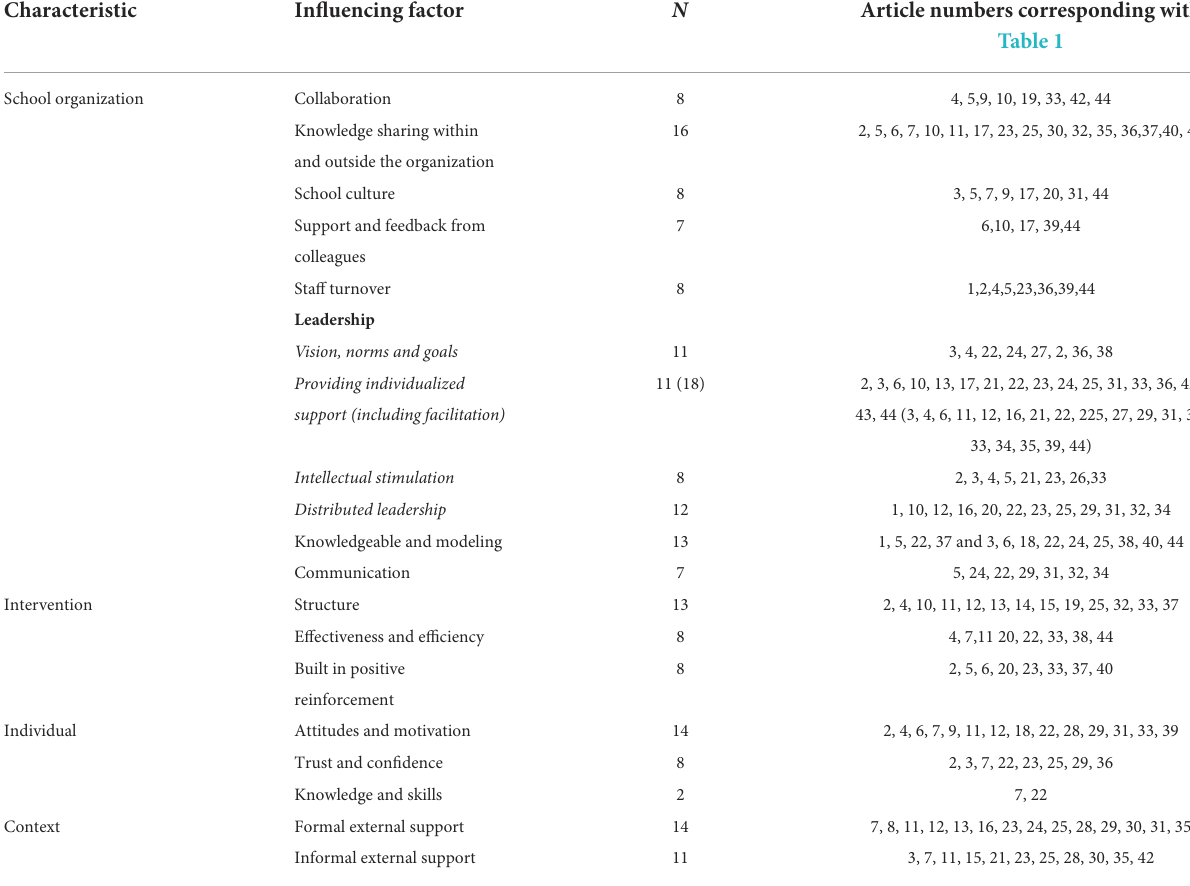
TABLE 3 Overview of division of influencing factors into categories, their frequency and corresponding articles. Characteristic